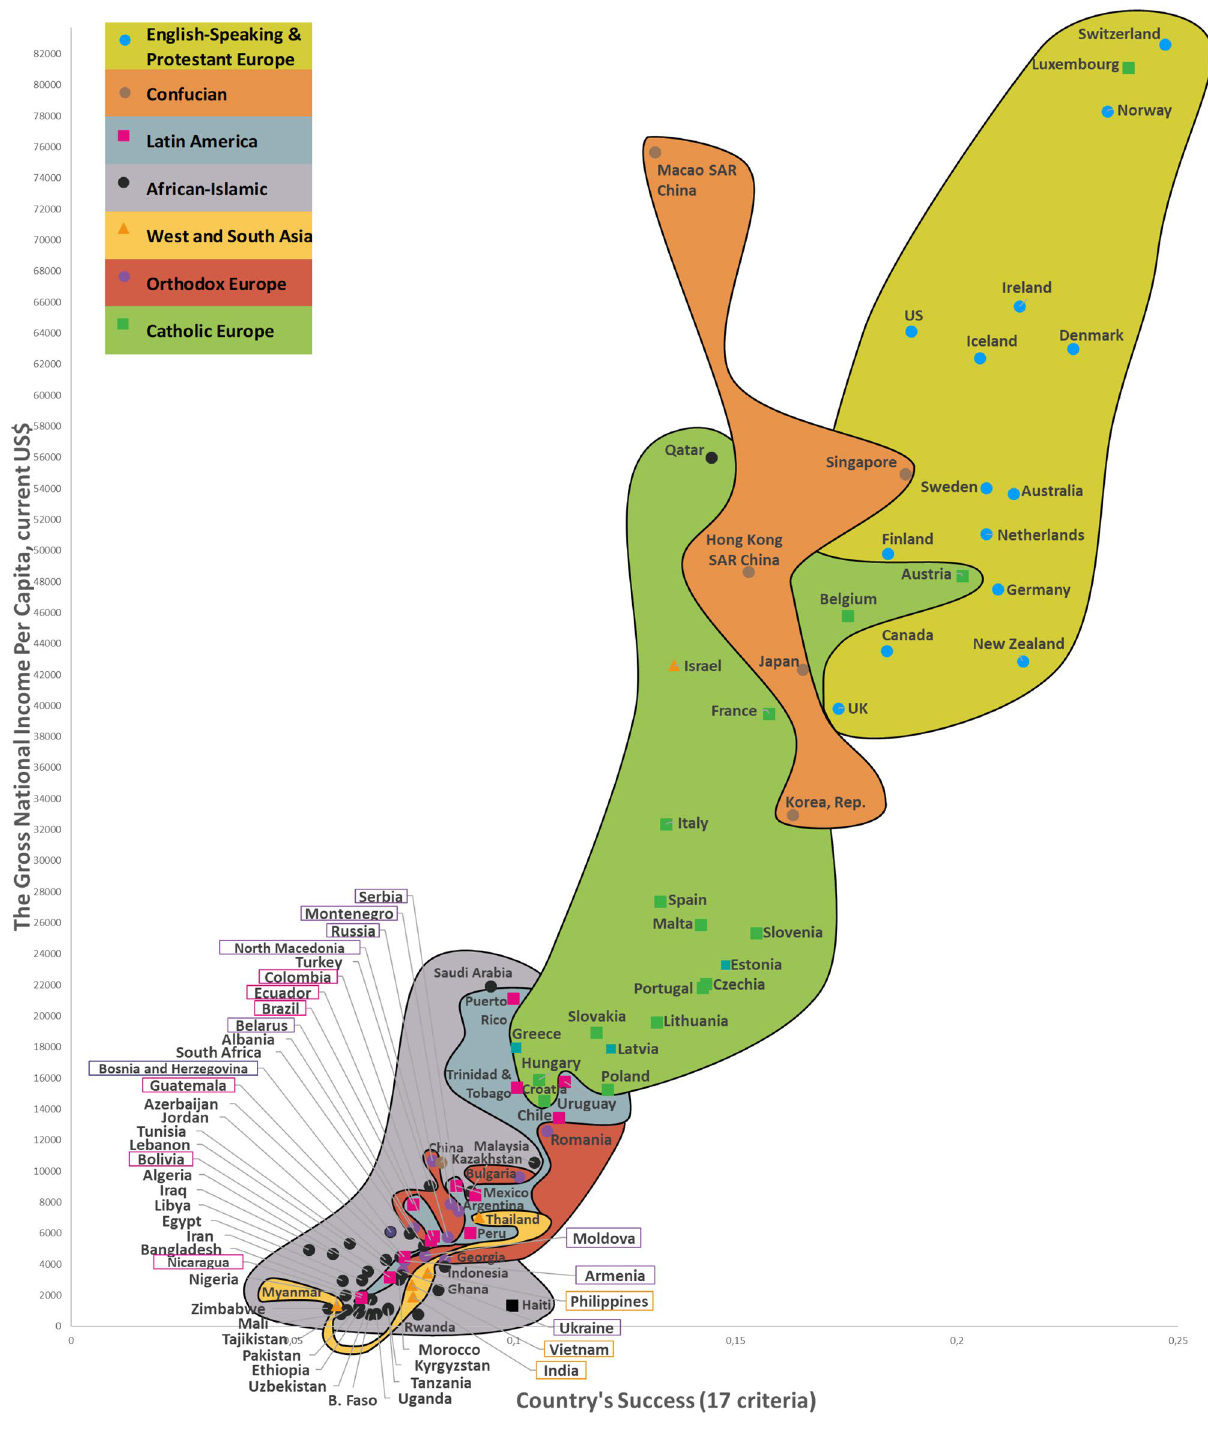
Figure 4. CSS gross national income per capita